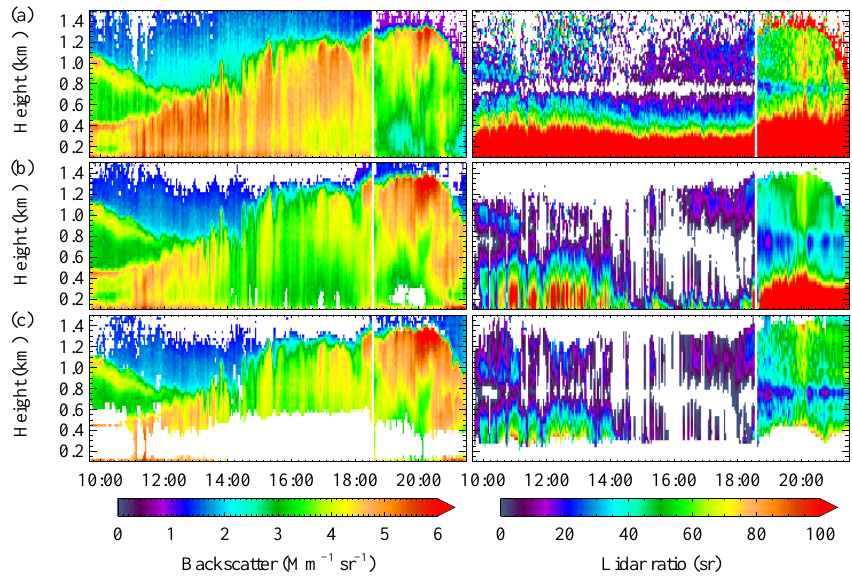
Fig. 15. The backscatter (left) and lidar ratio (right) retrieved from photon-counting CUV observations on 2 March 2010. Results with an error greater than 20% of β ( p ) or 30sr are plotted in white. (a) The Ansmann method after averaging the data over 30m to give a similar resolution to the retrieval. (b) Retrieval of β ( p ) and α ( p ) . (c) Retrieval of ln β ( p ) and B . The feature at 800m in all lidar ratios is due to an inaccurate estimate of N .